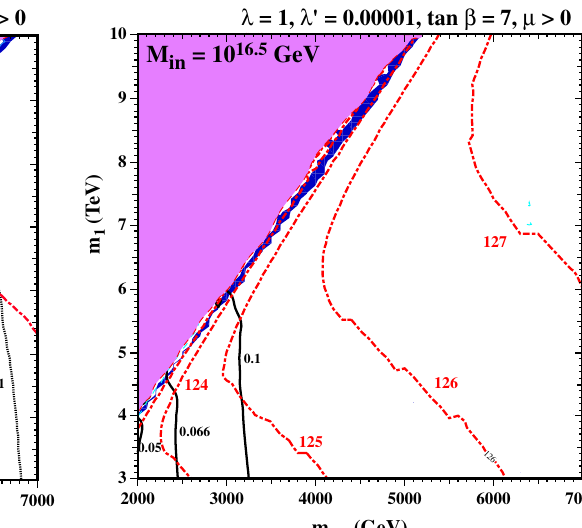
and λ = 1 ( right ). The shadings and contour colors are the same as in Fig. 1. The width of the relic density region ( shaded blue ) has been enhanced for better visibility. The pink shaded region corresponds to parameter choices where the electroweak vacuum conditions cannot be satisfied, and radiative electroweak symmetry breaking is not